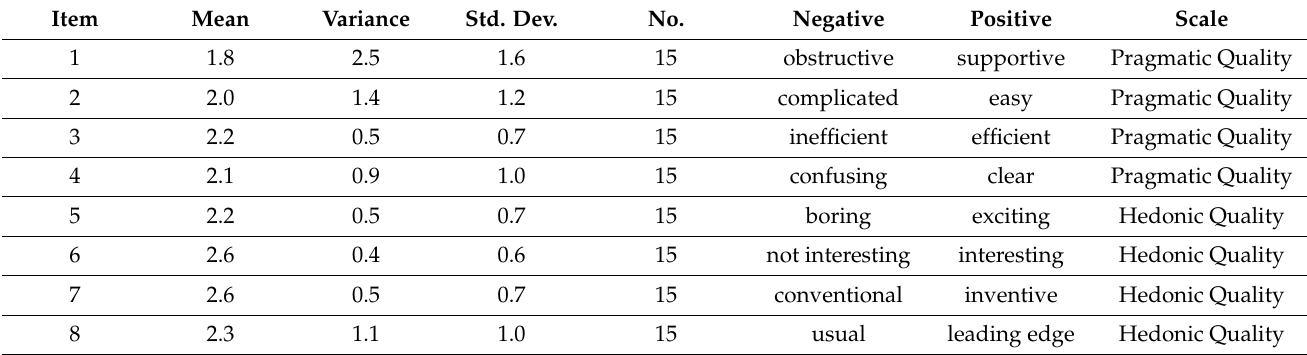
Table 3. Summary of the engineers’ answers to the